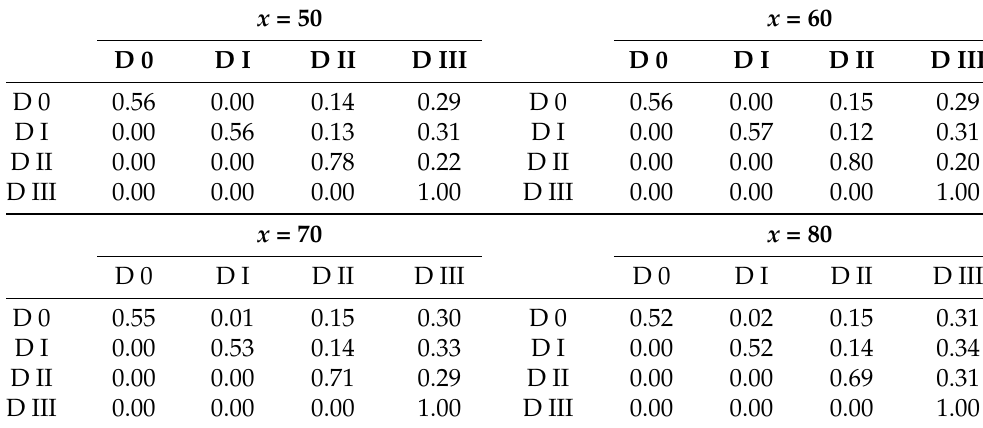
Table 3. Transition probabilities starting at certain ages